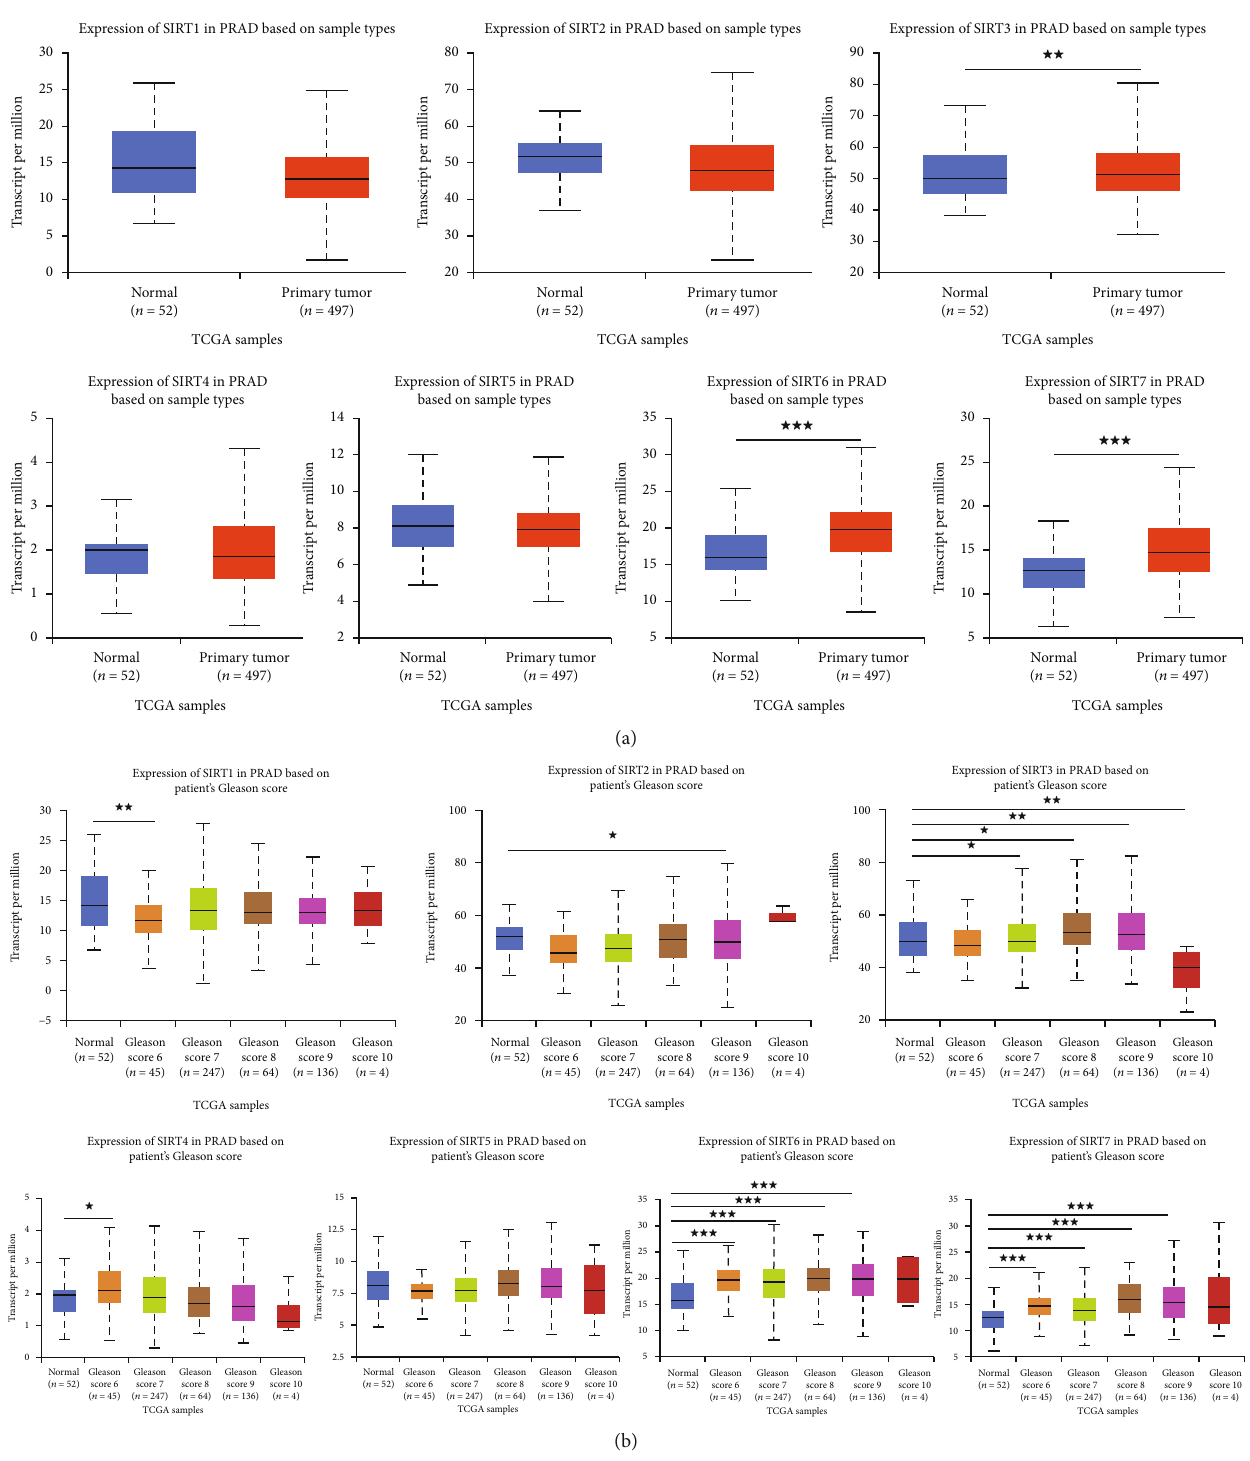
Figure 1: The higher expression of SIRT3 and SIRT6 in the PCa patients. (a) mRNA expression levels of SIRT3/6/7 were found to be overexpressed in primary PCa tissues compared to normal prostate samples. ∗∗ P < 0 : 01 and ∗∗∗ P < 0 : 001 . (b) Compared to the normal prostate tissues, the mRNA expression levels of SIRT3/6/7 in PCa samples were signi fi cantly correlated with the Gleason score; SIRT1/2/4/5 did not show consistent trend. ∗ P < 0 : 01 , ∗∗ P < 0 : 01 , and ∗∗∗ P < 0 : 001